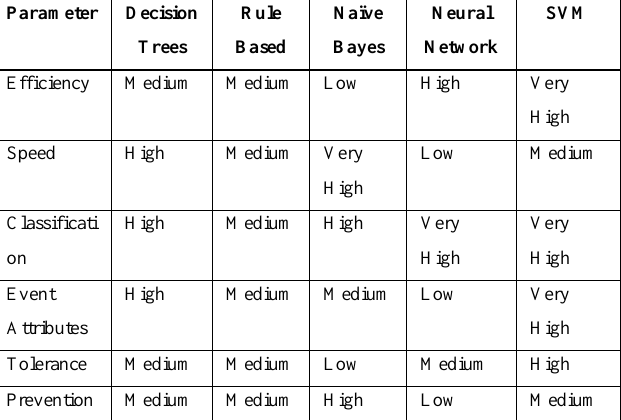
Table 1. Comparison of Learning Algorithms